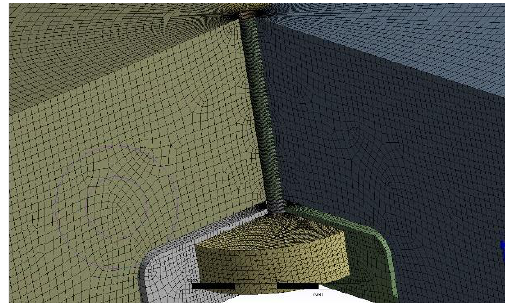
Figure 7. Results of grid division.